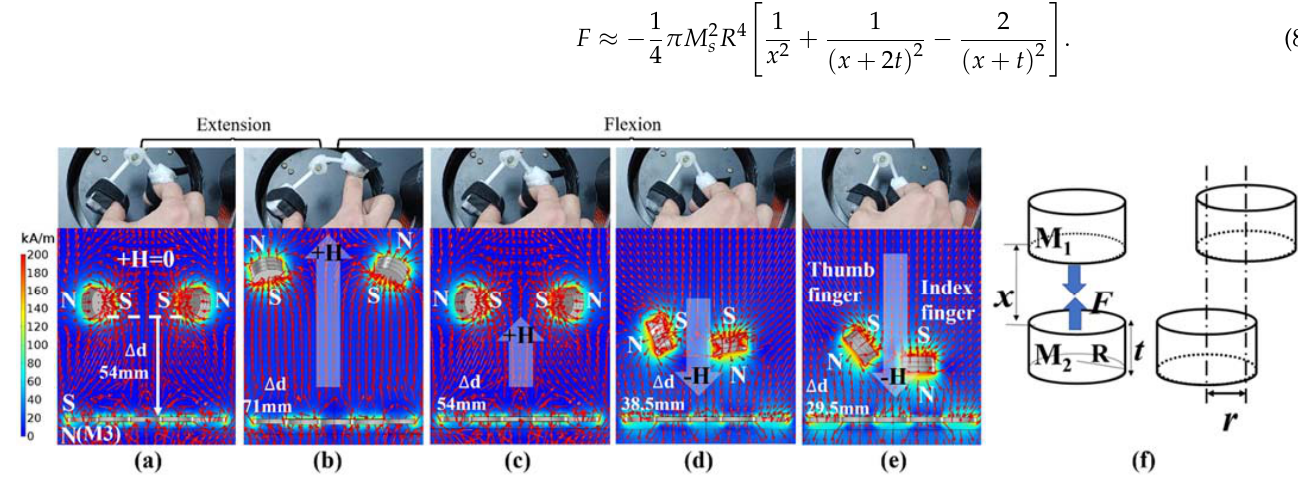
Figure 2. Magnetic simulation results according to changes in finger position due to driving current variations: ( a , b ) initial position and maximum extension of fingers during 0 to 25 A; ( c – e ) variations in flexion motions up to –25 A and their magnetic couplings in magnetic simulations; ( f ) magnetic force between two permanent magnets. (see Video S1)